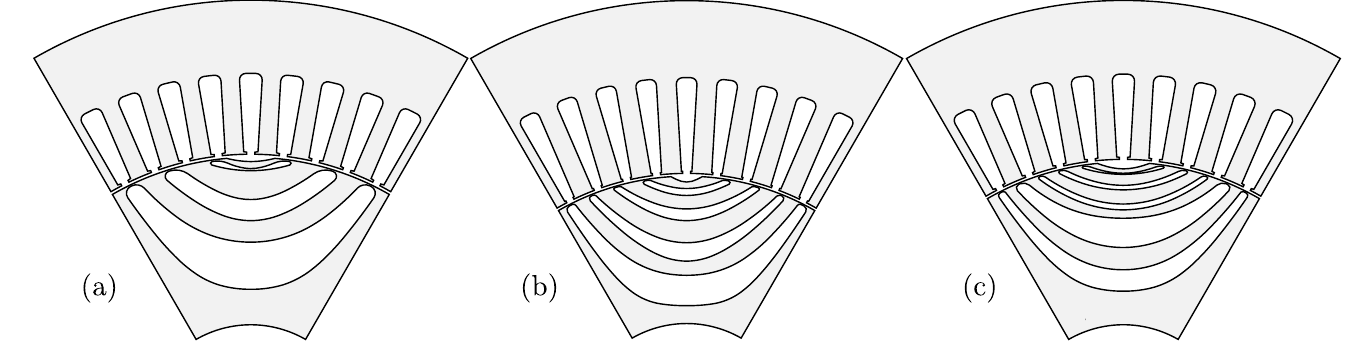
Figure 17. Optimized cross sections of MZhVD topology; ( a ) k = 3; ( b ) k = 4; ( c ) k =